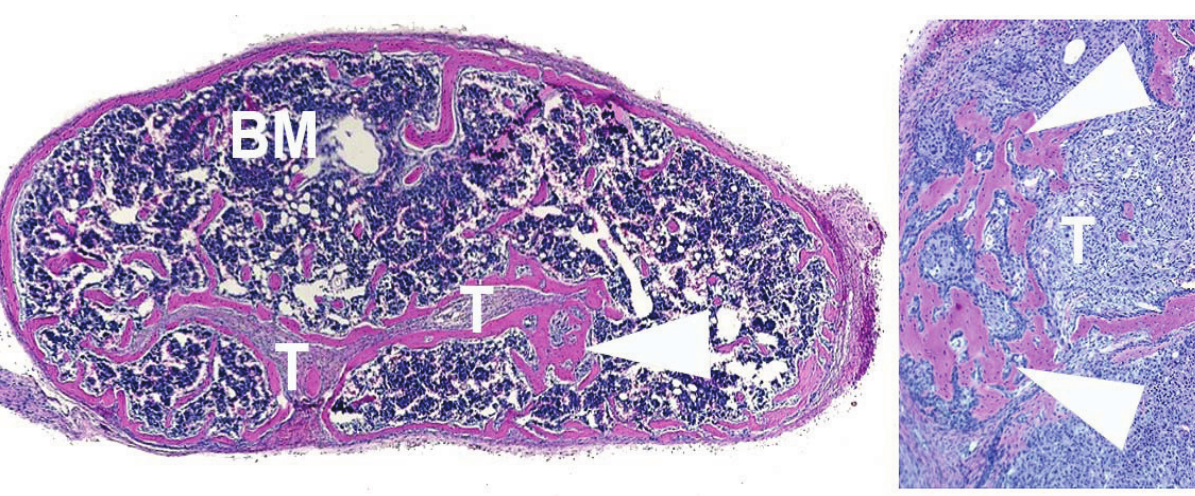
Figure 4. Nude mouse subcutaneously transplanted vertebral vossicle with canine Ace-1 tumor cells (T). The vossicle has cortical and trabecular bone with normal bone marrow (BM) hematopoietic cells (darkly stained cells). Note the new trabecular bone formation (arrowhead) induced by the Ace-1 tumor cells that surrounds the tumor cells. The image on the right is a magnification of the hyperplastic trabecular bone (arrowheads) induced by the Ace-1 tumor cells (T)